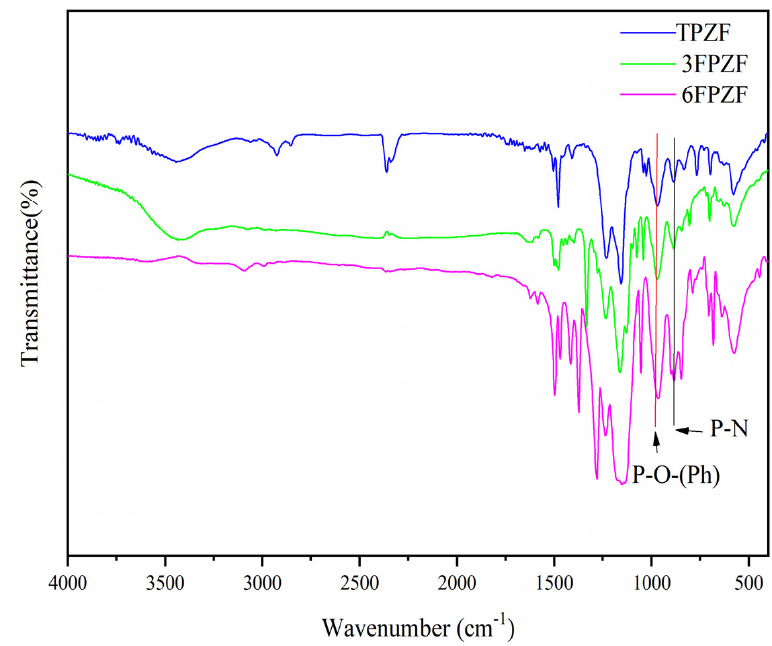
Figure 1. FT − IR spectra of 6FPZF, 3FPZF and TPZF micro-nanospheres.